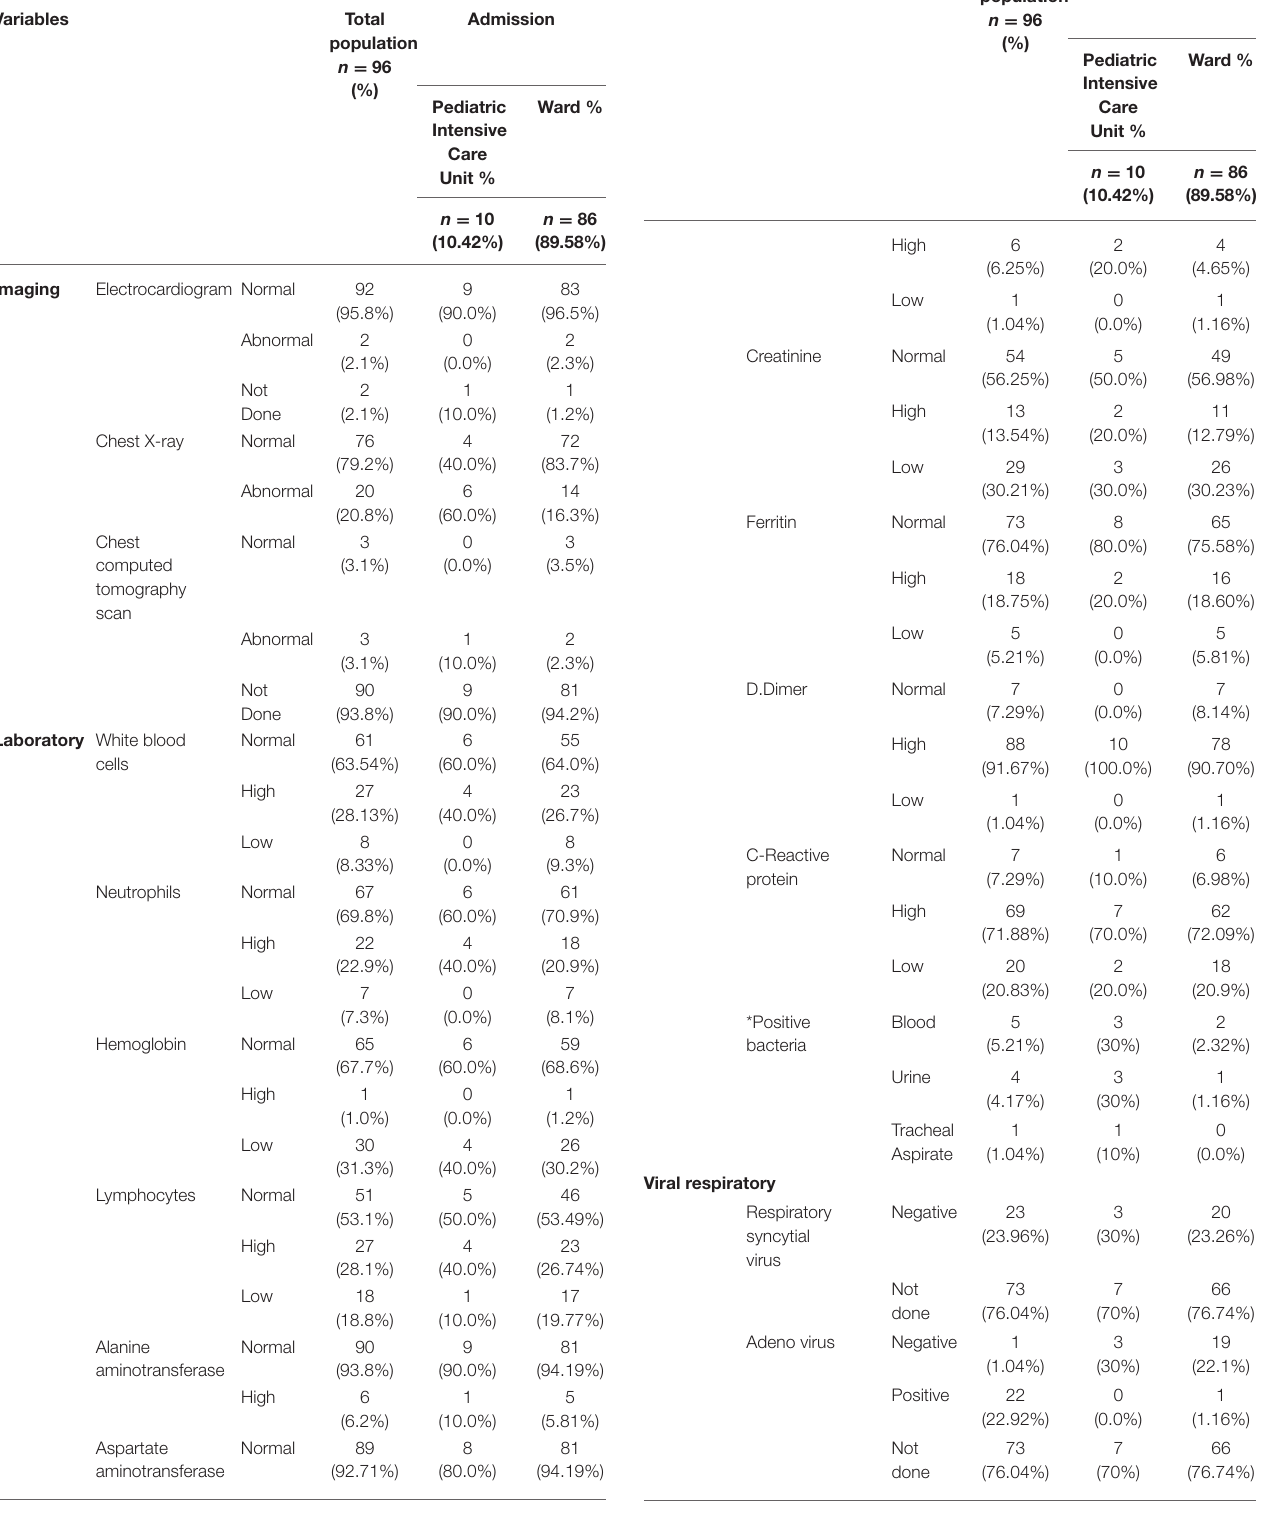
TABLE 3 | Labs and images associated with pediatric intensive care unit vs. regular ward admission of children admitted with confirmed COVID-19 infection ( n =